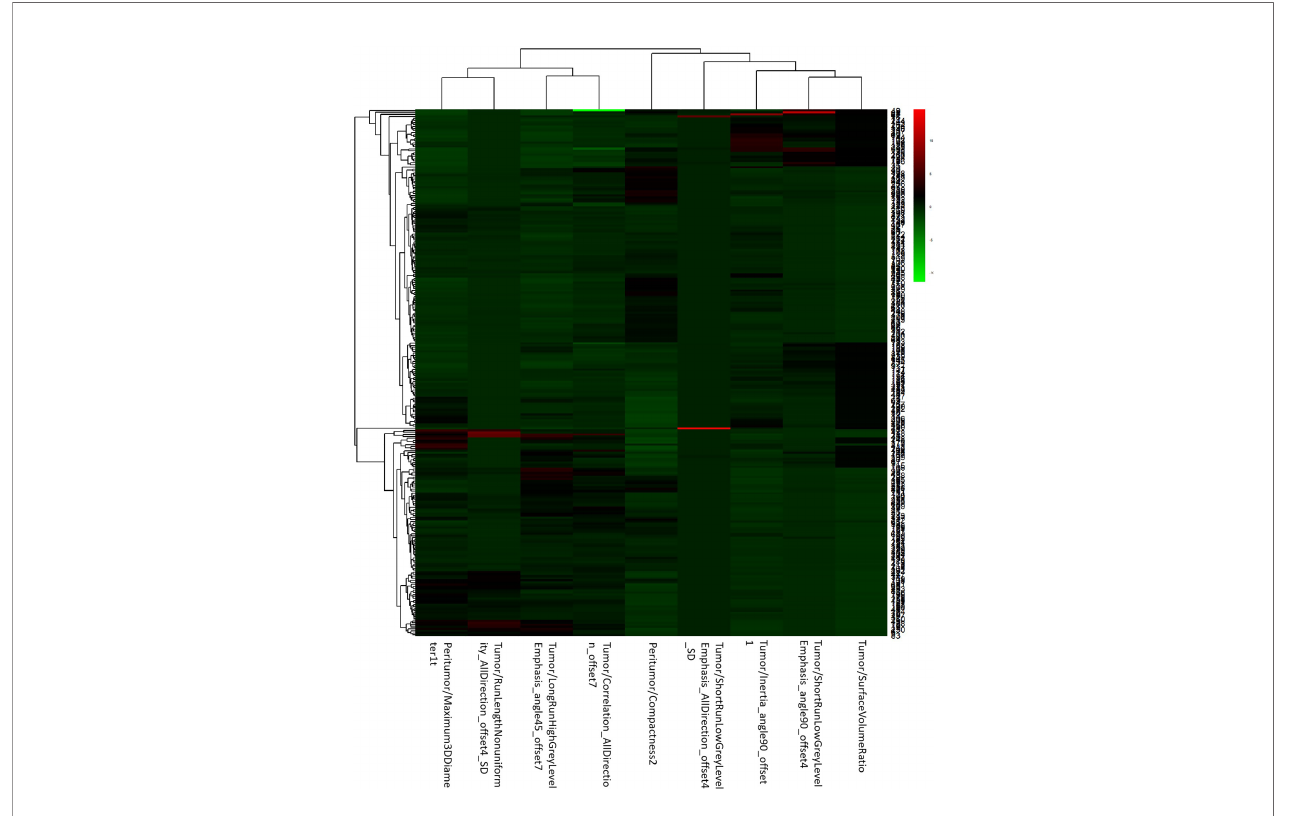
FIGURE 6 | The heat map of LR-tumor/peritumor included 9 selected radiomics features.